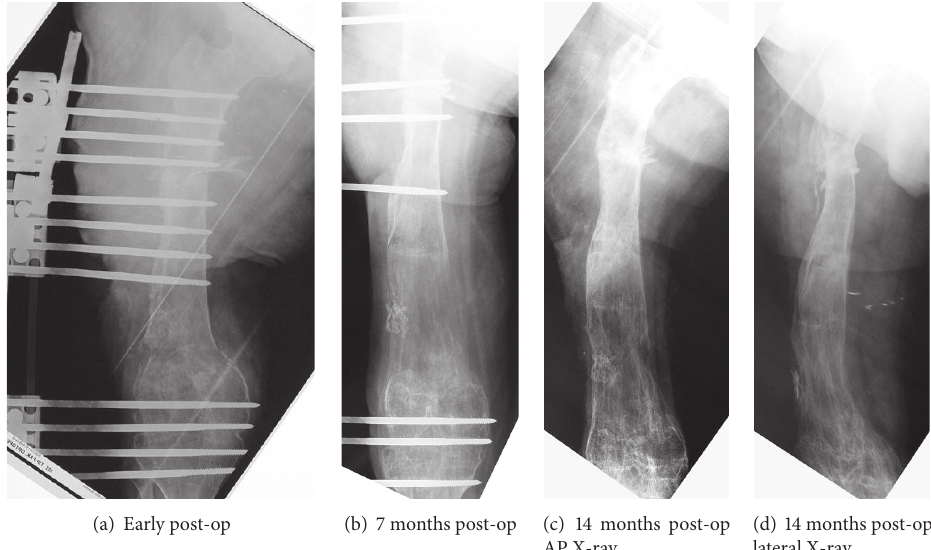
Figure 2: (a) Postoperative radiography of the femur. (b) Post-op 7-month radiography of the femur. (c, d) Post-op 14-month AP and lateral radiography.